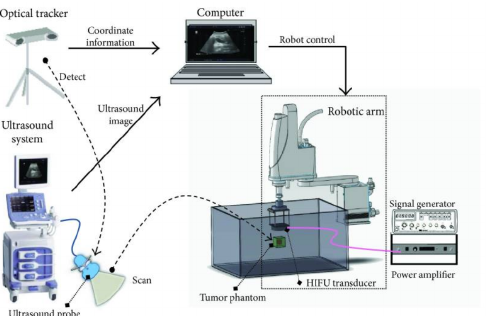
Figure 3. System overview of coordinate transformations between the ultrasound image and the SCARA robot frame developed by An et al.